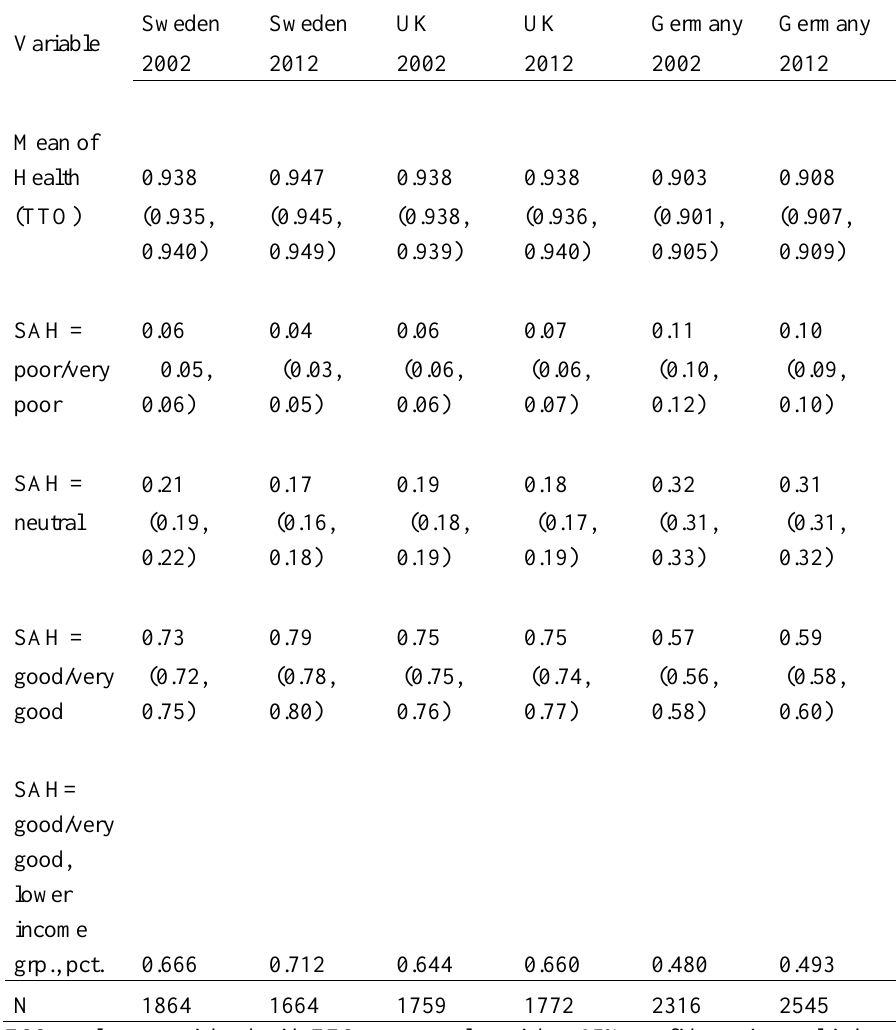
ESS results are weighted with EES post-sample weights. 95% confidence interval in brackets, Source: European Social Survey 2002 and 2012. (European Social Survey